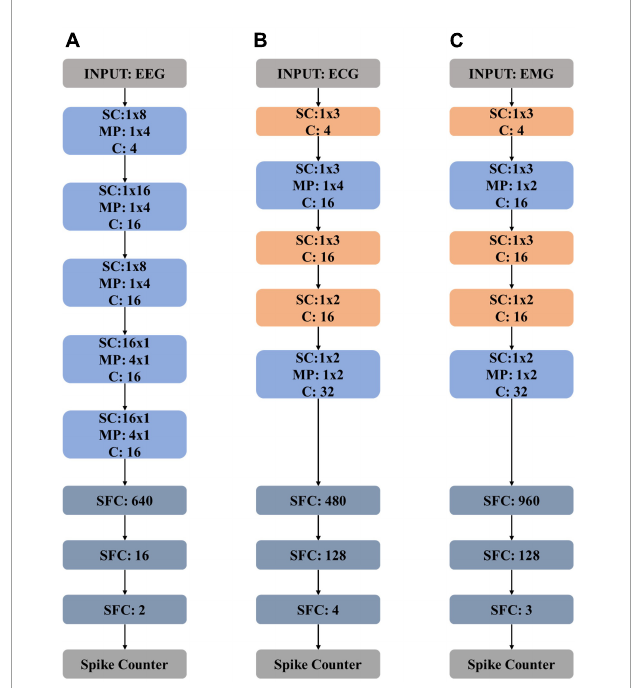
FIGURE4 Model structures of (A) electroencephalography (EEG) network, (B) electrocardiography (ECG) network, and (C) electromyography (EMG) network. “SC” stands for “spiking convolution”, “MP” stands for “max pooling”, “SFC” stands for “spiking fully connected” and “C” stands for